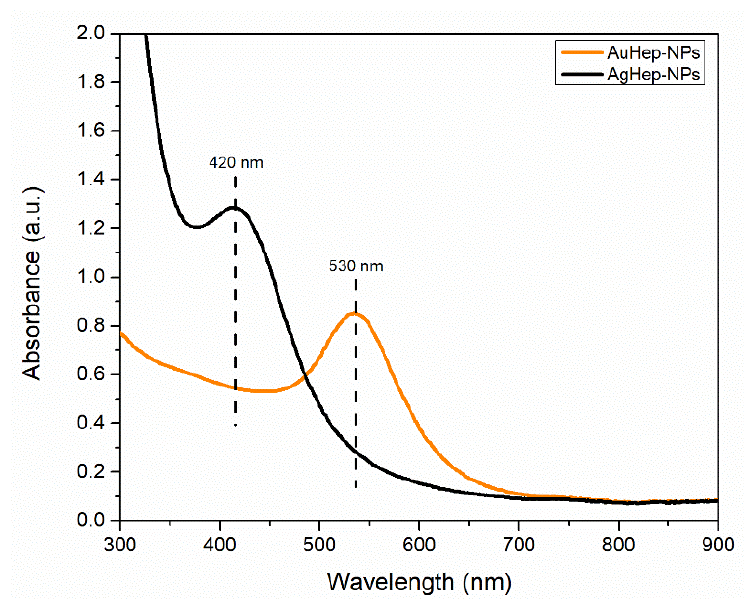
Figure 1. UV–Vis spectra showing plasmon resonance bands of the synthesized heparin-coated gold nanoparticles (AuHep-NPs) and heparin-coated silver nanoparticles (AgHep-NPs).